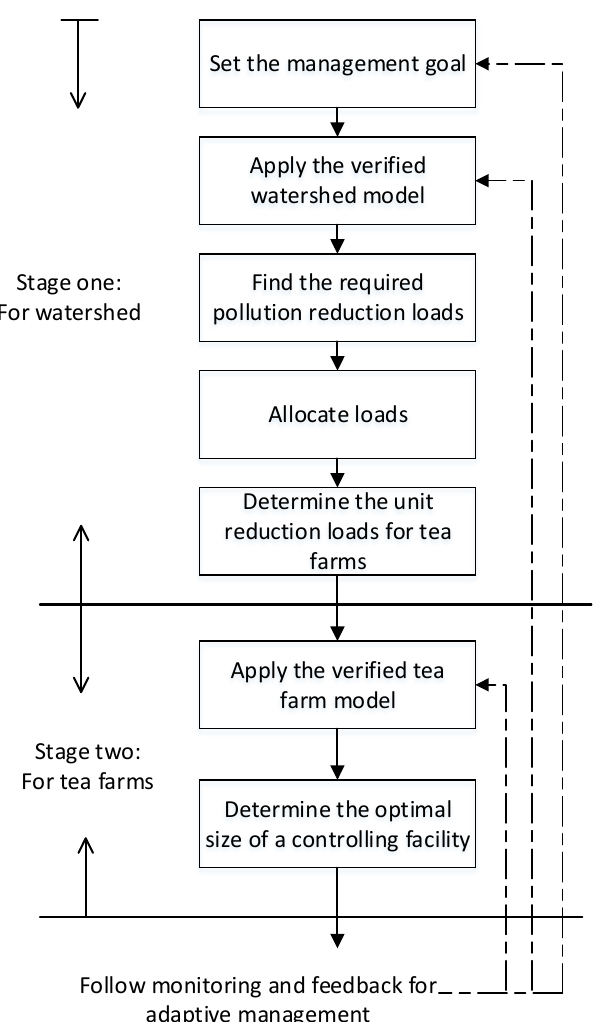
Figure 3. The two-stage optimization process for watershed and tea farm management.